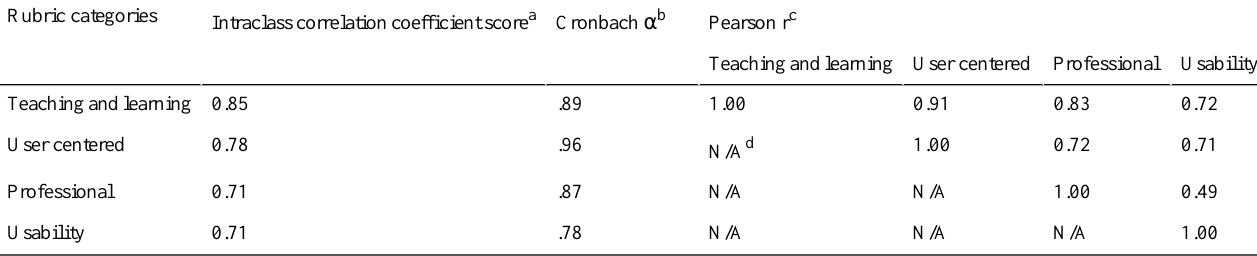
Table 2. Reliability statistics for the initial version of the Mobile App Rubric for Learning after review of 10 apps.